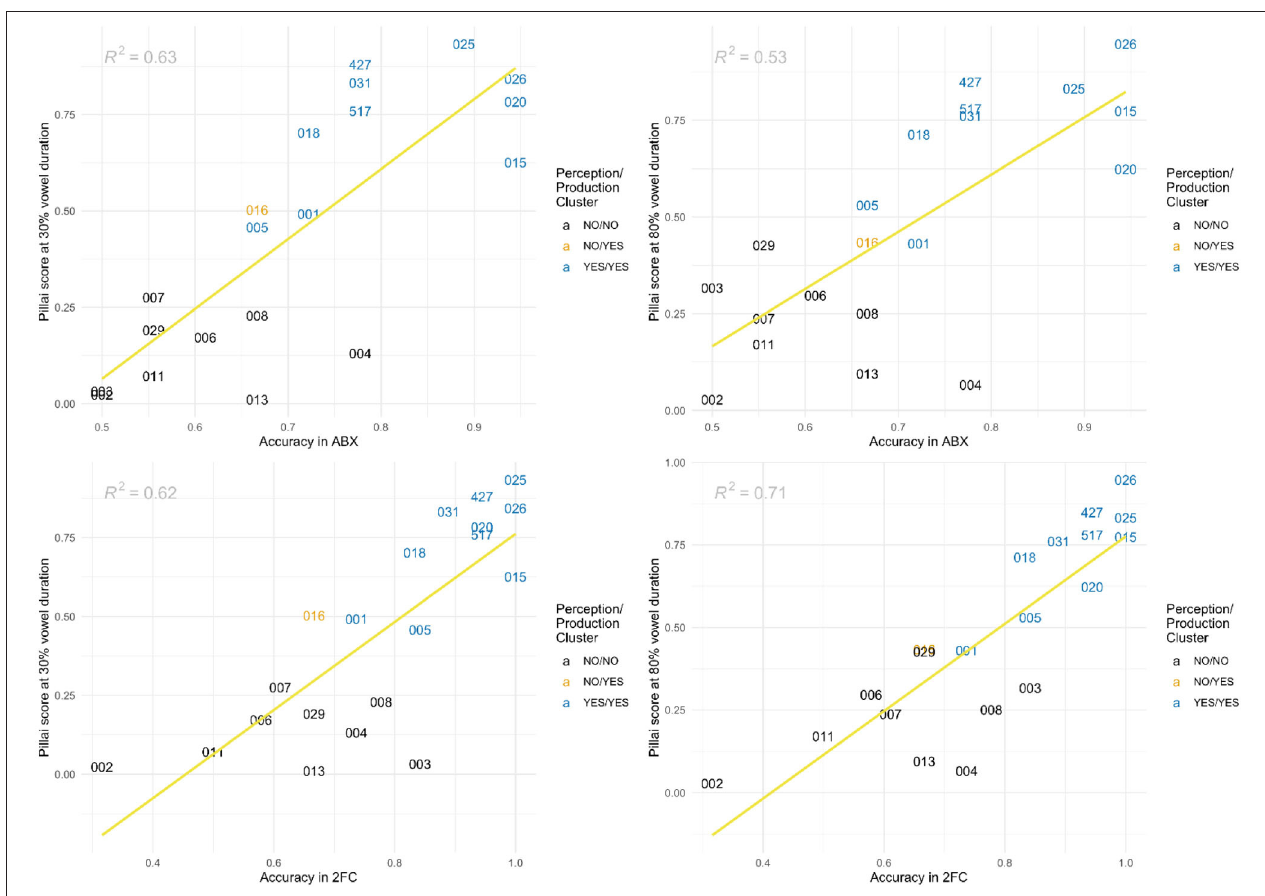
FIGURE 11 | Correlations between ABX perception accuracy and Pillai scores at 30% vowel duration (top left) and 80% vowel duration (top right) and between 2FC perception accuracy and Pillai scores at 30% vowel duration (bottom left) and 80% vowel duration (bottom right) for writer-rider. Participants are clustered based on perception and production independently, with the two clustering analyses visually combined to show 3 groups, where the first NO or YES of each label signifies the contrast in perception and the second signifies a contrast in production. NO/NO (participant clustered in the group with no contrast based on Pillai scores for both perception and production) is shown in black. NO/YES (participant in no-contrast group in perception, but in contrast group in production) is in orange. YES/YES (contrast in both perception and production) is in